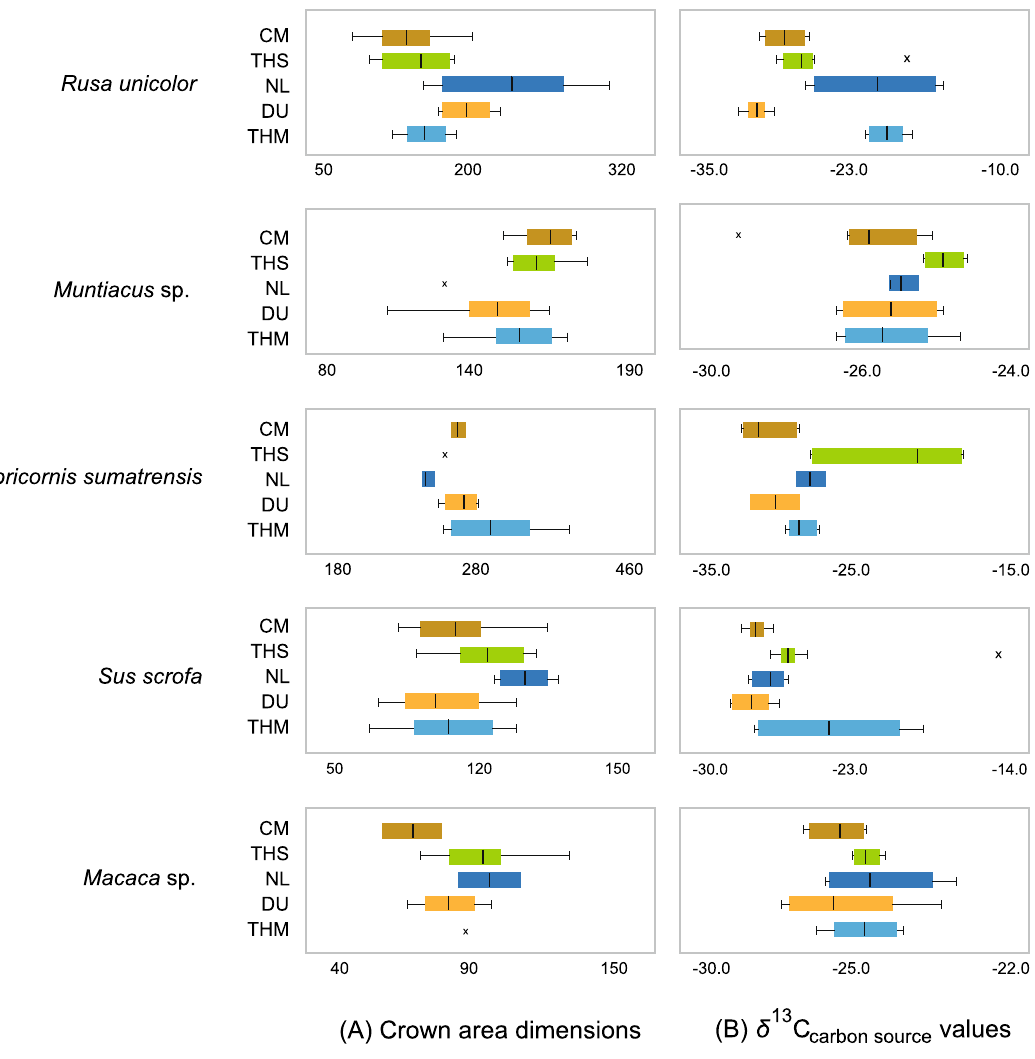
Figure 5. Distribution of crown area dimensions ( A ) and δ 13 C carbon source values ( B ) in five taxa (the boxes represent the 25th–75th percentiles, median and whisker plots), following a chronological sequence from the oldest (top) to the youngest (bottom). CM Coc Muoi, THS Tam Hang South, NL Nam Lot, DU Duoi U’Oi, THM Tam Hay Marklot. See Supplementary Table S13 for the number of